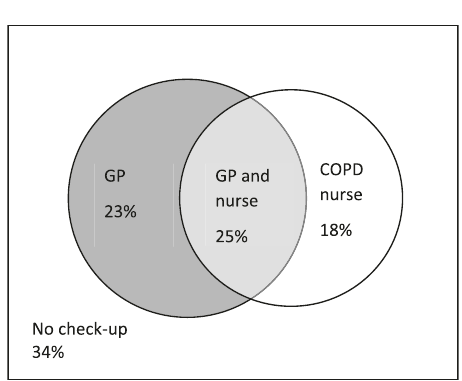
Fig. 2 Check-ups by general practitioner, COPD nurse, or both. Venn diagram showing the proportion of the study population having at least one check-up during the two-year period by a general practitioner (GP), COPD nurse or